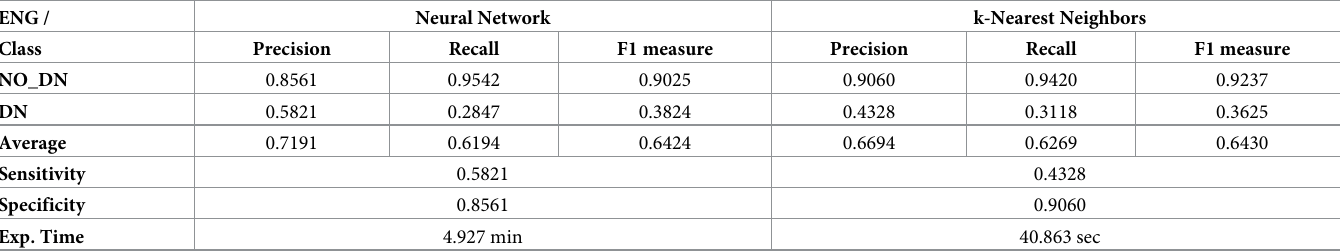
Table 9. The prediction results obtained using both classifiers for ENG dataset.